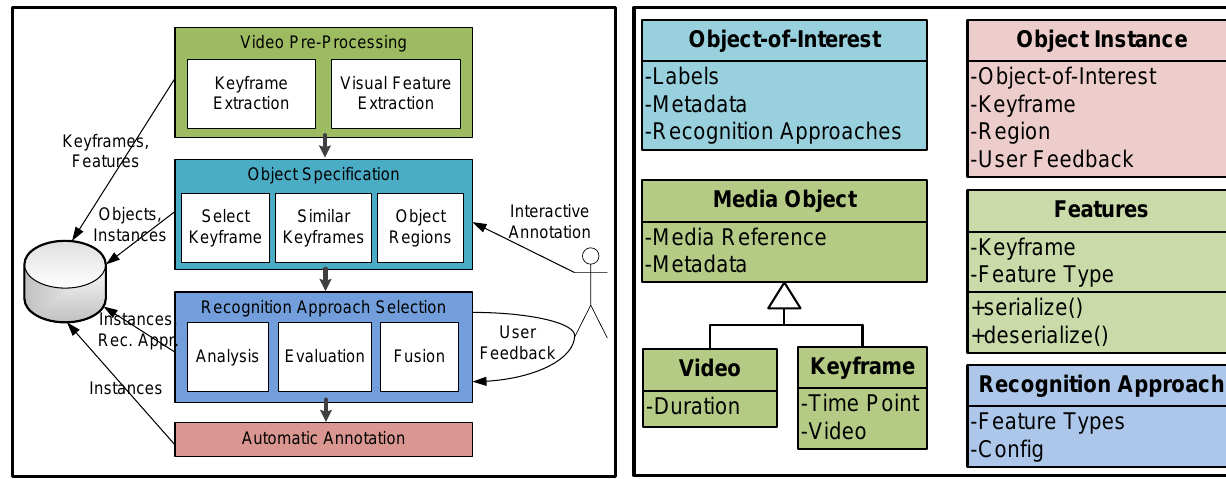
Figure 2. Annotation workflow (left) with the associated database schema